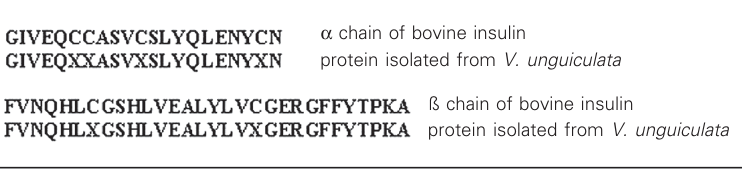
Figure 3. Alignment of the sequence found by automatic amino acid sequencing of the fraction isolated by RP-HPLC of cowpea ( Vigna unguiculata ) insulin with the sequence of bovine insulin (gi229095). Sequences were compared using the NCBI-BLAST search system. Cysteine residues were not detected since proteins were not reduced/alkylated; an X appearing in the sequence indicates that the amino acid at that position is probably a cysteine